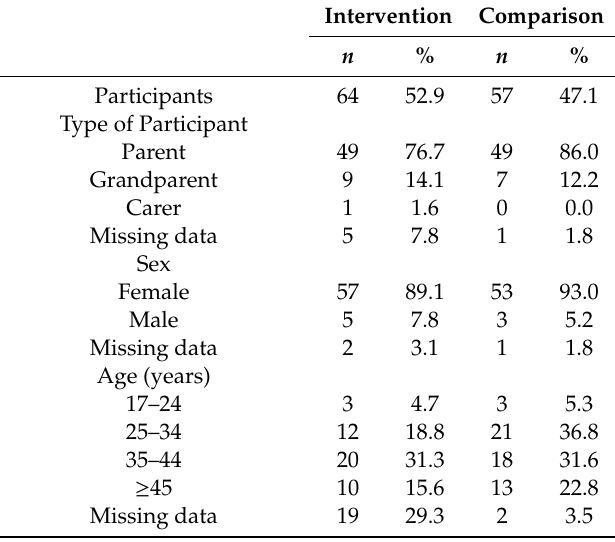
Table 2. Demographic characteristics of intervention and comparison participants and